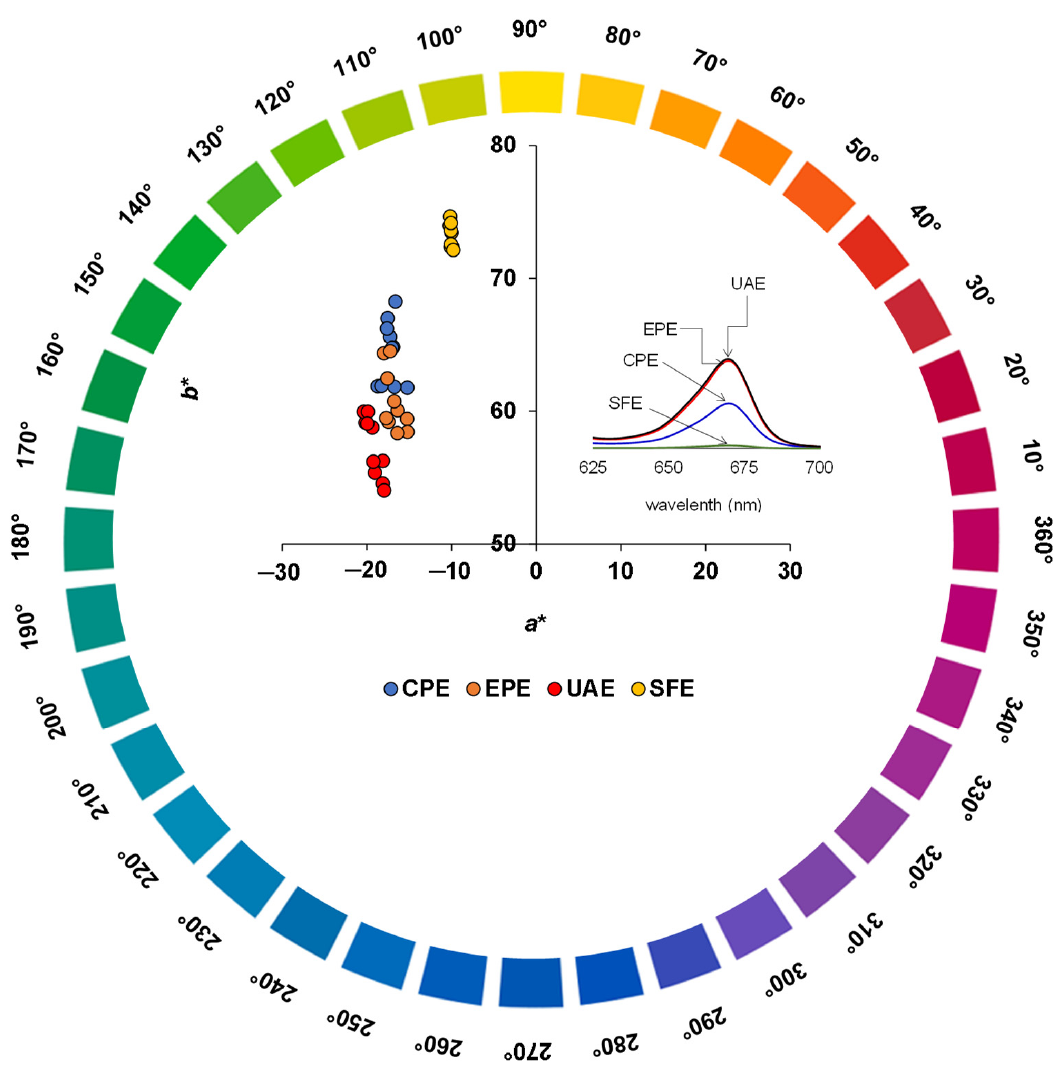
Figure 3. Colorimetric coordinates for the different sinami oil extraction systems within the a * b * plane.